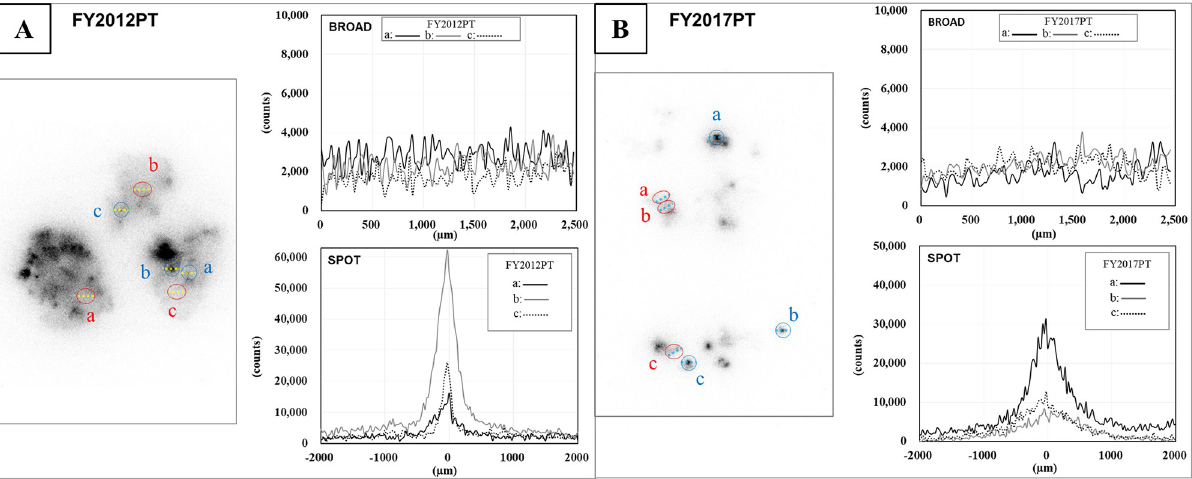
Fig 2. Signal intensity patterns of the typical distribution examples in the areas of the FY2012PT and FY2017PT sample shown in Fig 1. (A) FY2012PT sample. (B) FY2017PT sample. Left panel: line scan position (yellow dotted line in A, aqua dotted line in B) in the images for autoradiogram acquisition. Right panels: linear intensities of the selected areas in the left panel. Upper right panel: “broad distribution”; lower right panel: “spot distribution”. The intensities ranged from ca. 400 to 4 000 in the broad distribution. The x-axis shows the linear distance of the distribution ( μ m), and the y-axis shows the PSL signal intensity value (counts) in both graphs. The x-axis is aligned with 0 in the spot distribution.